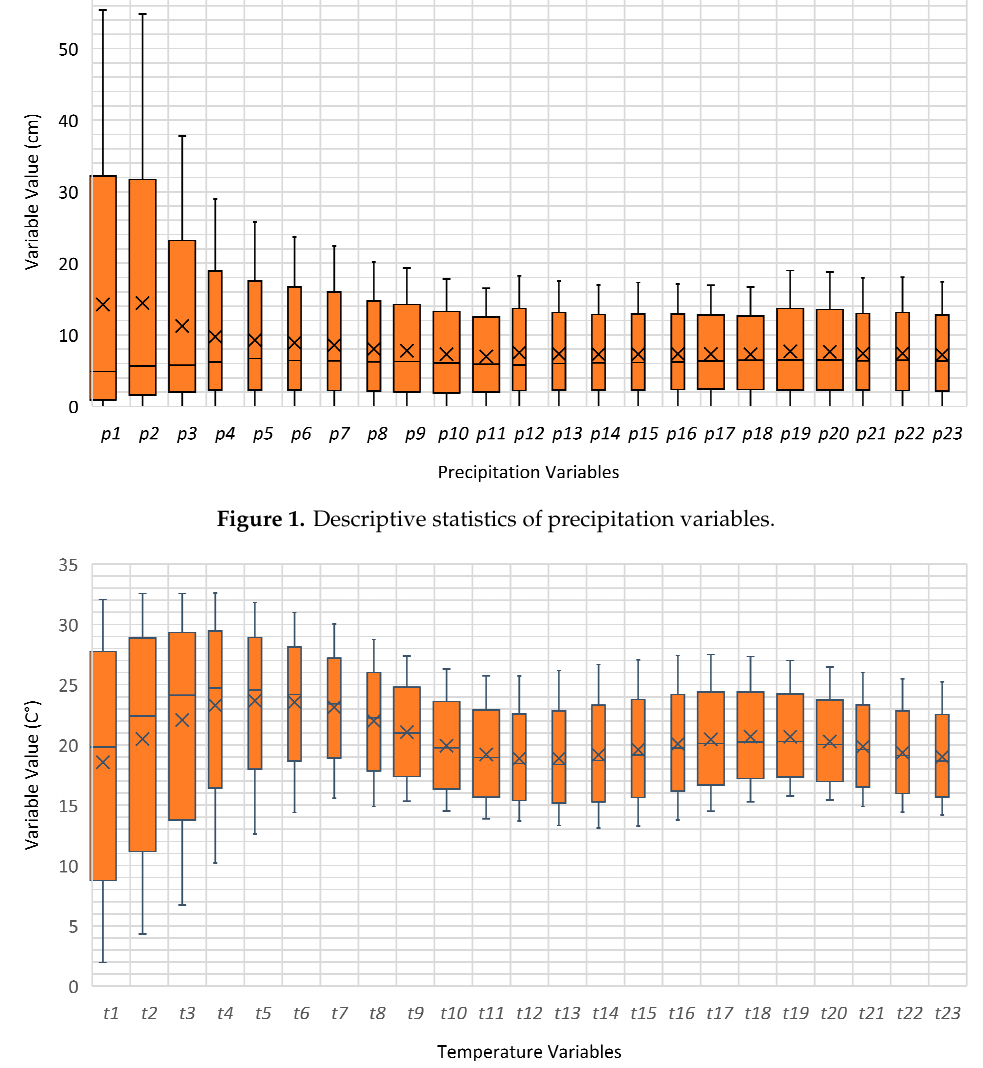
Figure 2. Descriptive statistics of temperature variables.